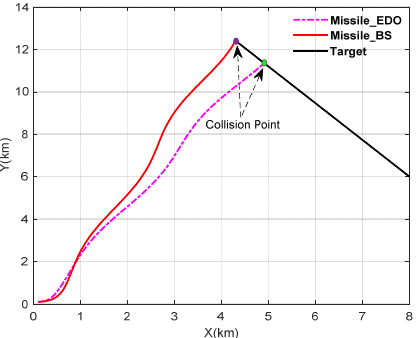
Figure 3. The maneuver characteristics of the target.